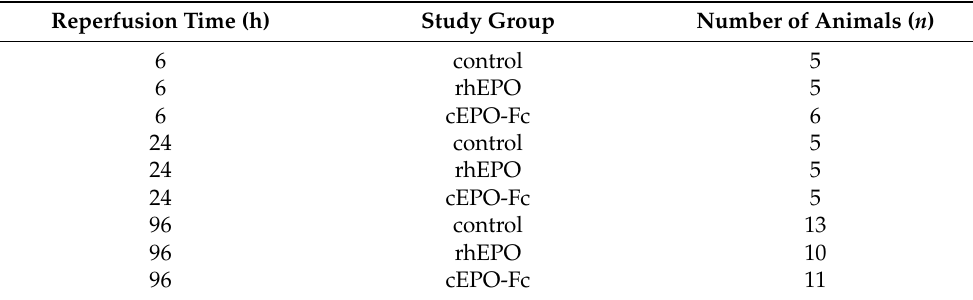
Table 3. Study groups and the number of